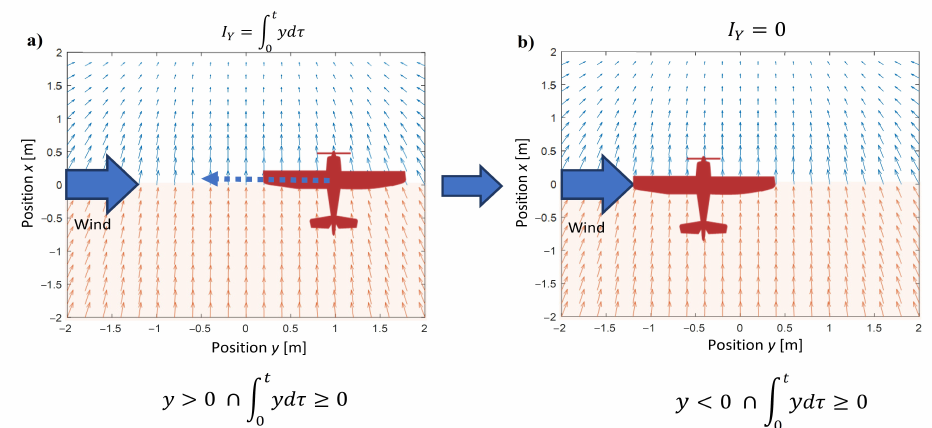
Figure 4. Switching a value of I ( y ) according to the relative position of a UAV in respect to the tracked point and the direction of wind gust. ( a ) the value of I ( y ) is different than zero, ( b ) the value of I ( y ) equals